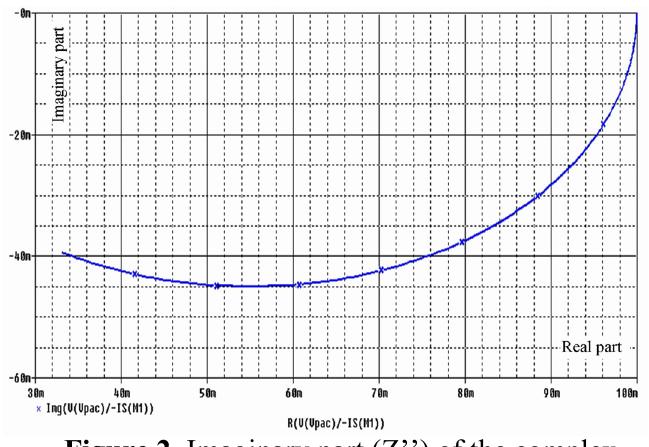
Figure 2. Imaginary part (Z’’) of the complex impedance (Z*) versus real part (Z’), Nyquist plot